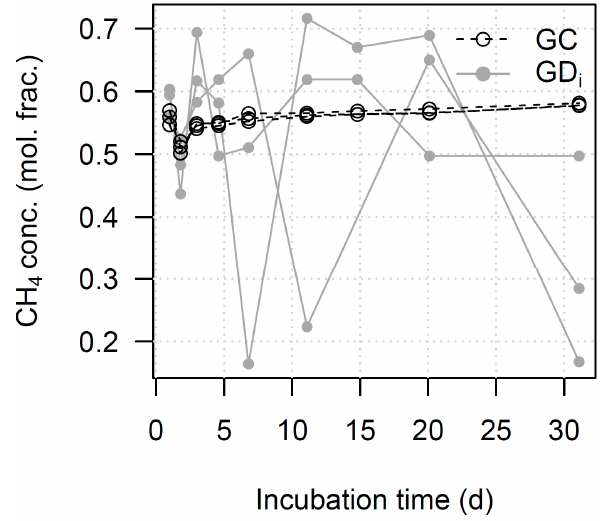
Figure 4. Comparison of interval total gas density (GD i ) and gas chromatography (GC) estimates of biogas CH 4 content for a single substrate (FI1) from Experiment 1A. Unlike the complete total gas density method (GD t ), the GD i method is not recommended for general use.